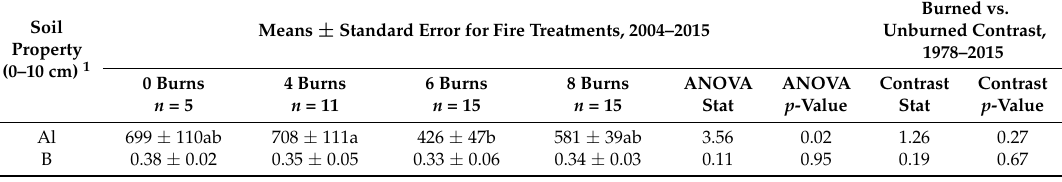
Table 1. Soil chemical property means ( ± standard error) at the 0–10 cm soil depth based upon fire frequency from 2004 to 2015 and linear contrast results for fire inclusion from 1978 to 2015 at the Tom Yawkey Wildlife Center, Georgetown, SC, USA. Means with different lowercase letters are statistically different at α =